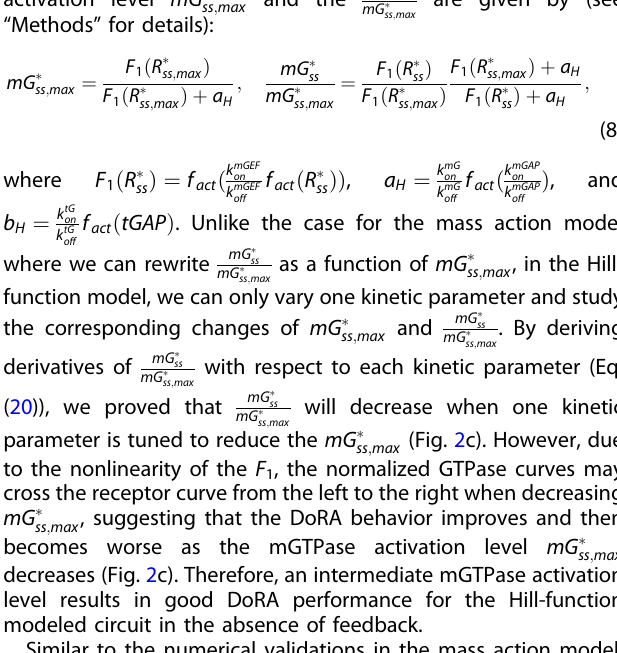
Fig. 2 The relations between the DoRA behavior and the mGTPase activation level in the circuit without feedback. a The DoRA behavior improves with the decreased mGTPase activation level when tuning one kinetic parameter in the mass action model. b Numerical validations for results in A by tuning k mGAP . The upper panel: the distance metric vs the mGTPase activation level when increasing k mGAP on ↑ ) for a given parameter set. The middle panel: percents of maintaining the trend in the upper panel when searching the parameter k mGAP on ; k tG space f k mG . The bottom panel: the distance metric vs the mGTPase activation level in the parameter space f k mG on on g dashed red line the mean and the error bar the standard deviation. See Supplementary Table 1 for parameters. c The DoRA behavior improves and then becomes bad with the decreased mGTPase activation level when tuning one kinetic parameter in the Hill-function model. d Same plot as in B except that the Hill-functions kinetics is adopted. The parameter space also expands to include the k R receptor activation level and thus the mGTPase activation level in the Hill-function